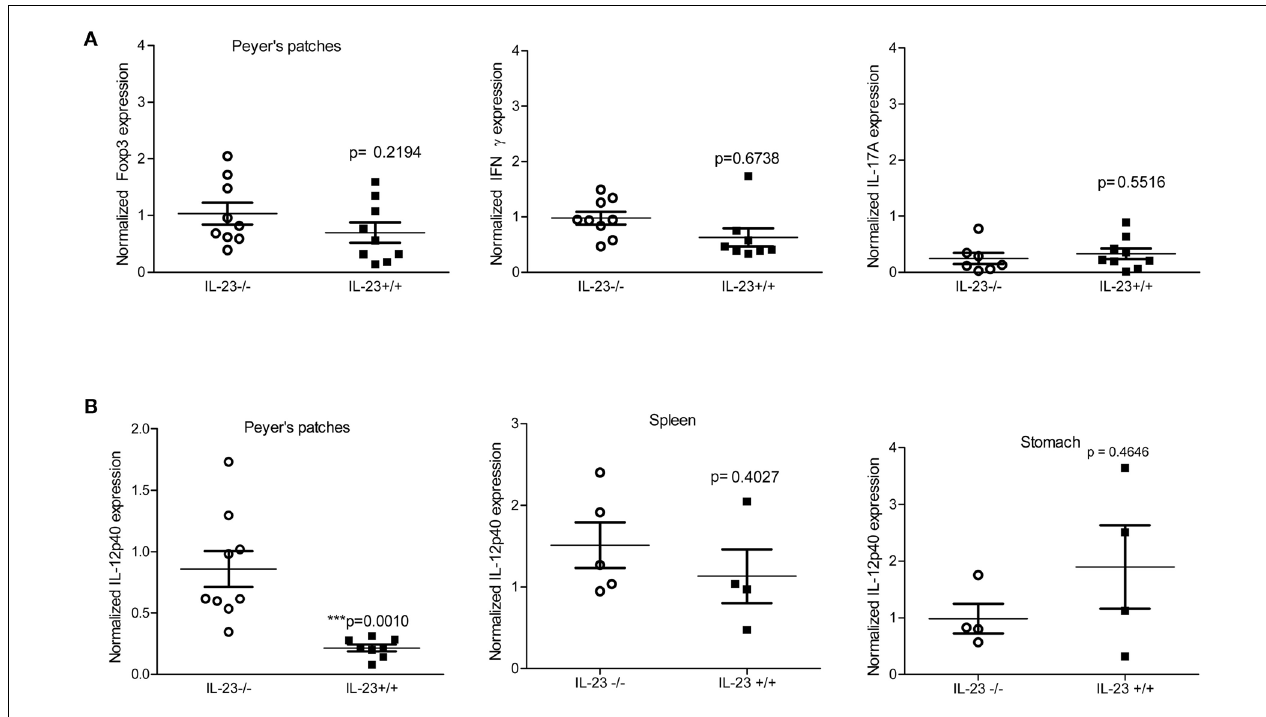
expression calibrated to uninfected wild-type with GAPDH as the endogenous control. Due to differences in IL-12p40 in the Peyer’s patches, IL-12p40 expression was also measured in the spleen and gastric mucosa (B)